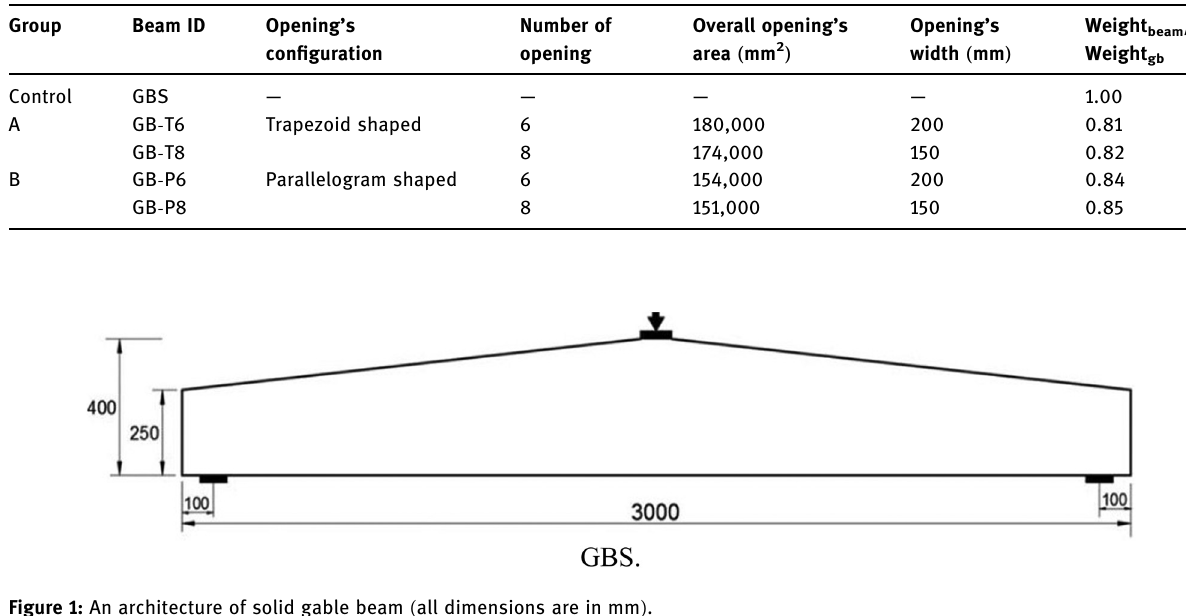
Table 2: Details of tested beams